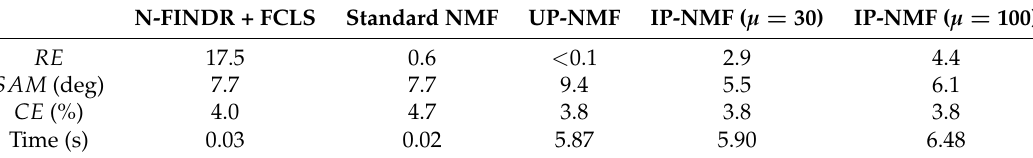
Figure 9. Evolution of the RE (blue curve) and the SAM (green curve) as a function of µ parameter. Table 1. Global comparison of unmixing